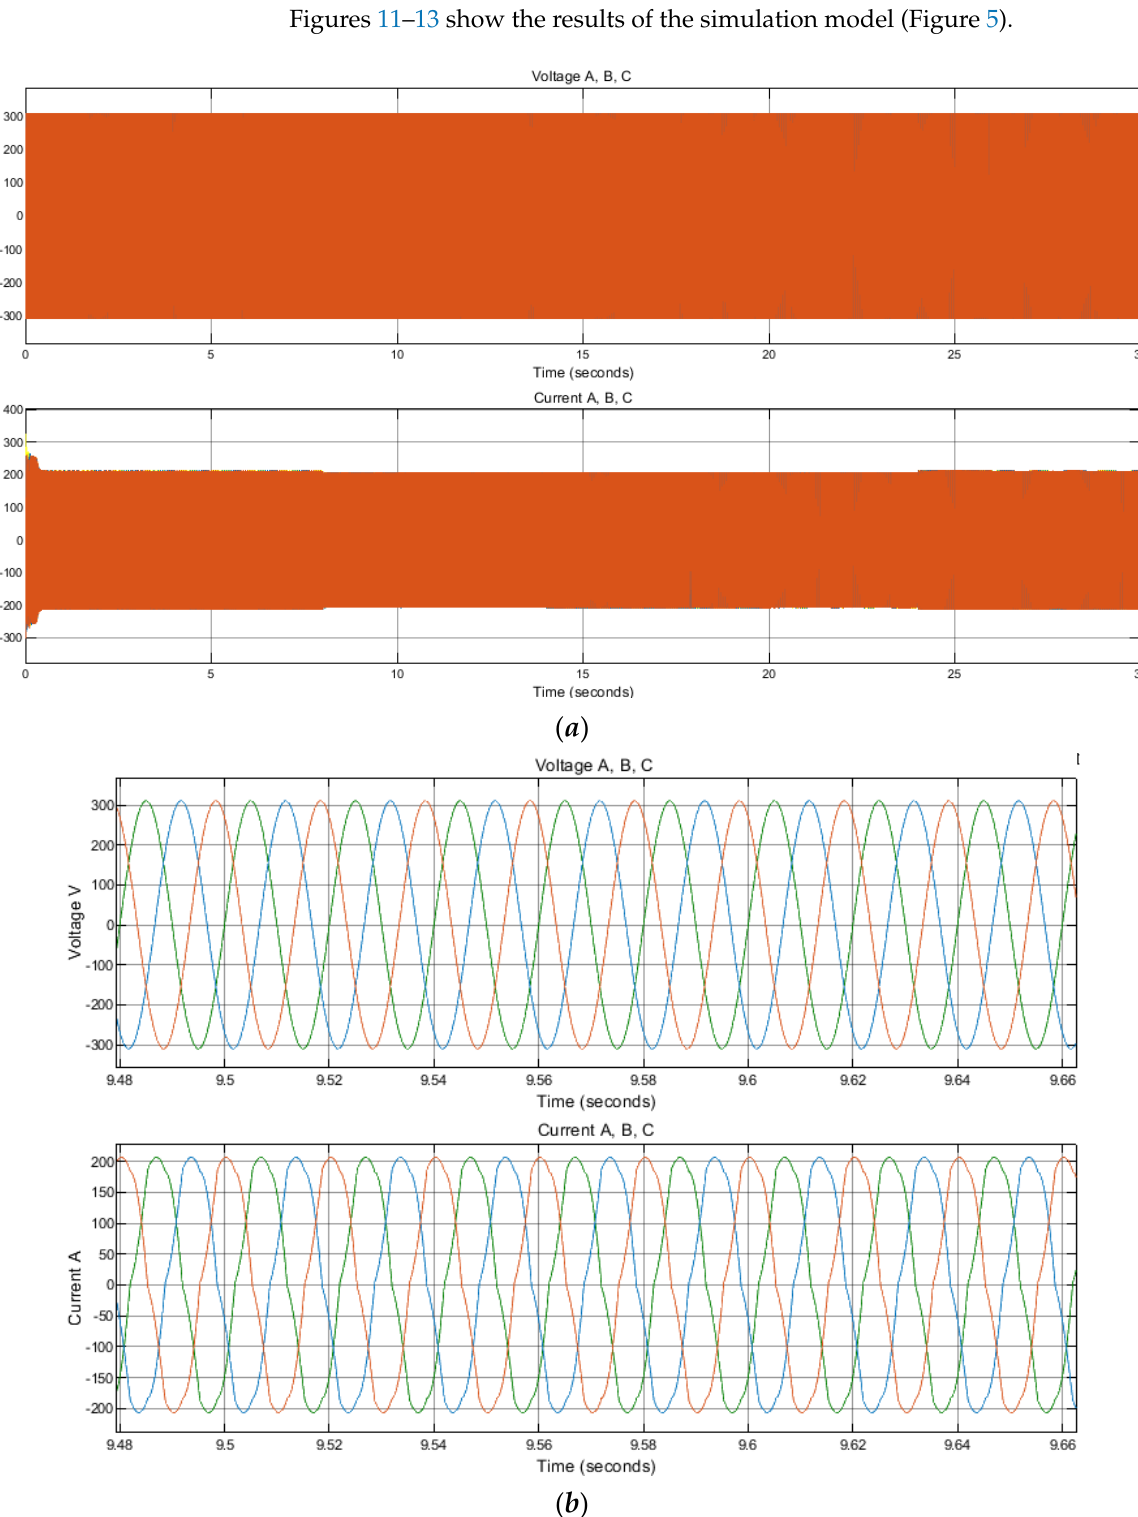
Figure 11. Results of the power supply system simulation model for a group of asynchronous motors. ( a ) —general level of current and voltage changes on the common bus; ( b ) —shapes of current and voltage on the common bus.